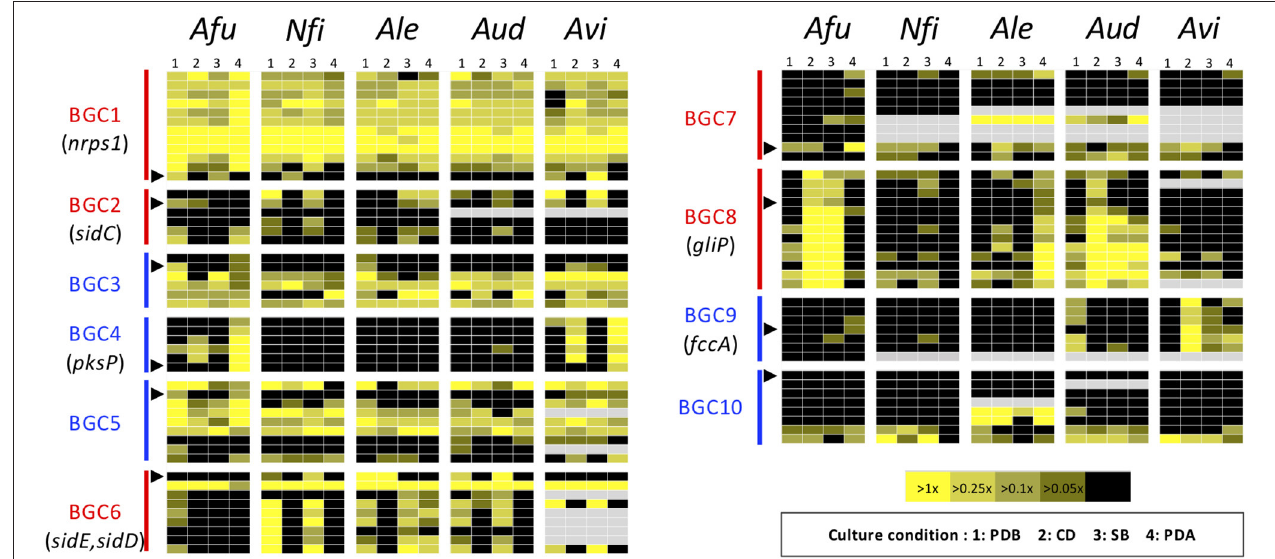
FIGURE 5 | Heat map revealing expression profiles of the genes in ASF-conserved biosynthesis gene clusters. The color of the bar between the biosynthesis gene cluster (BGC) ID and the panels indicates the type of SM backbone gene, as follows: red: NRPS or NRPS-like; blue: PKS or PKS-like. A black triangle indicates the SM backbone gene in the BGC. Gray panels indicate the absence of the corresponding gene. Afu, A. fumigatus; Nfi, N. fischeri; Alu, A. lentulus; Aud, A. udagawae; Avi, A. viridinutans